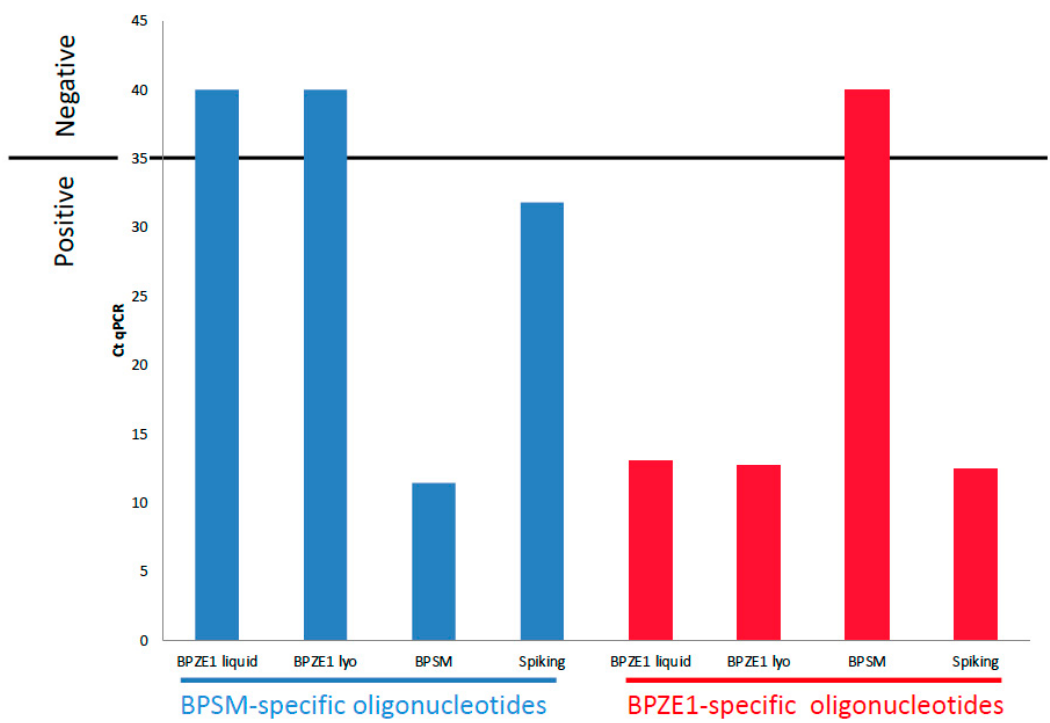
Figure 2. q-PCR amplification of the PT S1 subunit-coding DNA. The S1 subunit gene of the liquid BPZE1 drug product (BPZE1 liquid), the lyophilized BPZE1 drug product (BPZE1 lyo), BPSM and BPSM-spiked lyophilized BPZE1 (Spiking) was amplified by PCR using the BPSM-specific (blue) or BPZE1-specific primers (red), as listed in Table 1. The horizontal line indicates the cut-off in numbers of amplification cycles (Ct qPCR) indicating whether a sample is considered positive ( ≤ 35 cycles) or negative ( ≥ 35 cycles).